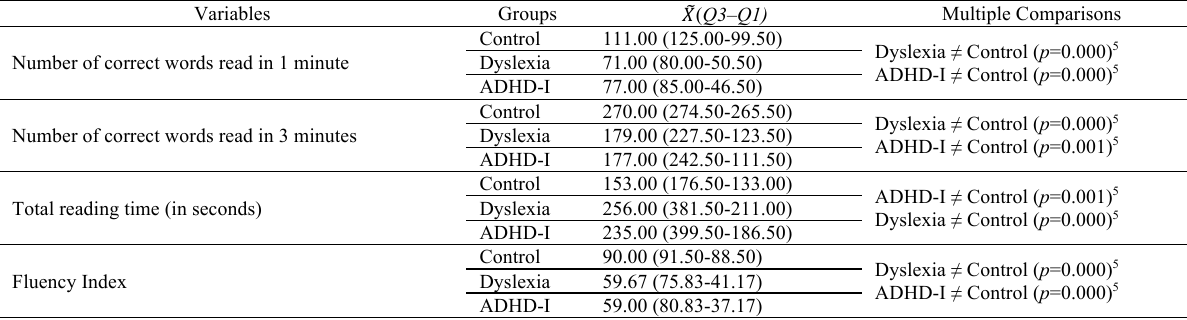
Table 14 – 1 st and 3 rd percentiles and Kruskal-Wallis independent samples: O Rei – Reading Fluency and Accuracy Test